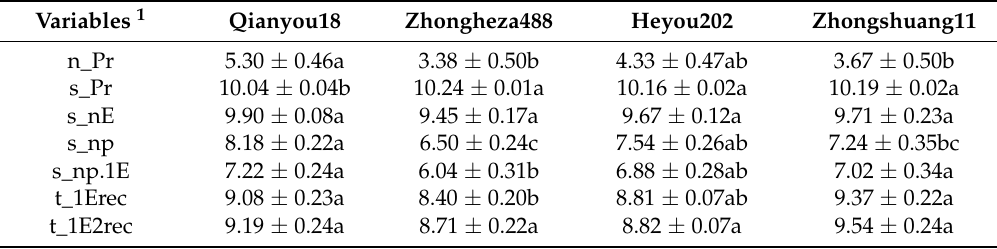
1 The values in the table show means ± stand error (SE). The data were compared using the analysis of variance (ANOVA) followed by the unrestricted least significant differences (LSD) after the square-root transformation for frequency variables, and natural log transformation for time variables. The level for significance was set to P < 0.05. The values followed by the same lowercase letter within a row represent no statistical differences among the four cultivars. The acronym of the variables in the first column was defined in Table 1.